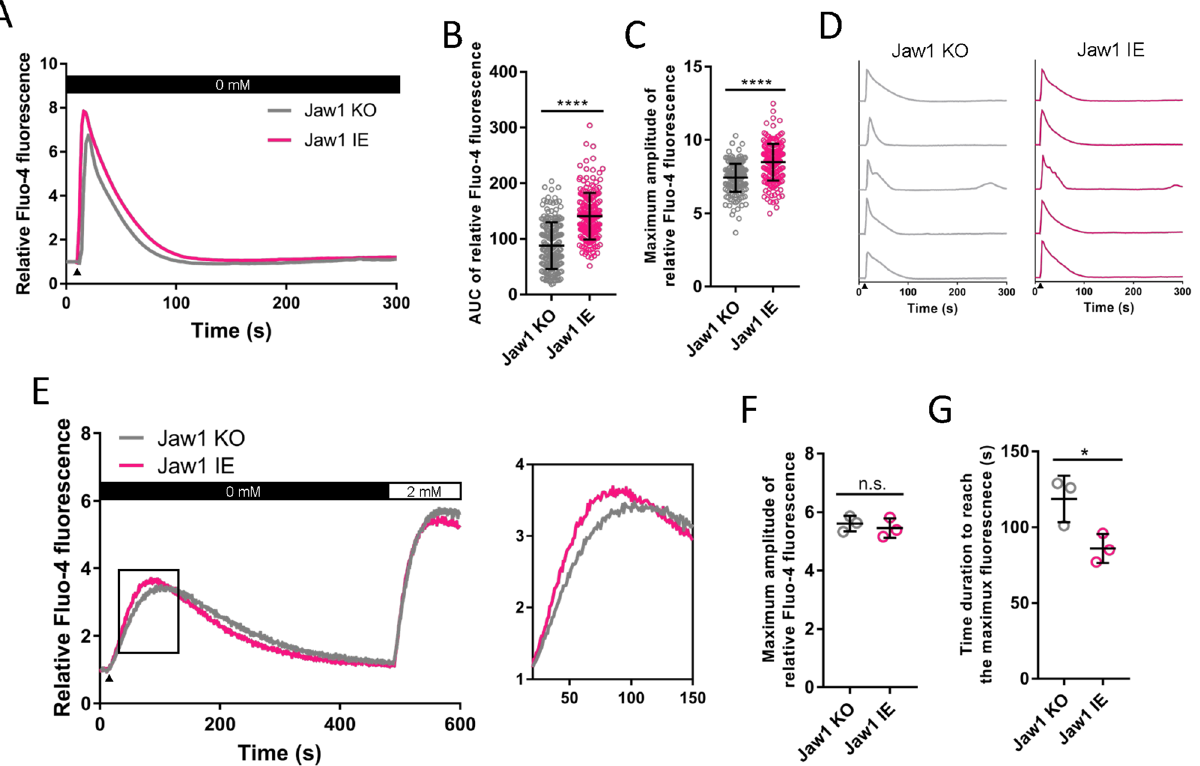
Figure 4. Jaw1 accelerates Ca 2+ efflux from ER . ( A , D ) Mean ( A ) or five representative ( D ) curves of the relative intensity upon 100 µM ATP stimulation under extracellular Ca 2+ free condition in Jaw1 KO and Jaw1 IE cells. n = 200. The closed triangle shows the time point of 100 µM ATP solution supplementation. ( B , C ) AUC ( B ) or maximum amplitude ( C ) of the relative intensity from ( A ). ( E ) Mean curves of the relative intensity upon Ca 2+ depletion in the ER by 2 µM thapsigargin supplementation in 0 mM Ca 2+ and replenishment with 2 mM Ca 2+ . The closed triangle shows the time point of 2 µM thapsigargin solution supplementation. The area surrounded with a black box is enlarged in the right. n = 3. ( F , G ) Maximum amplitude in SOCE ( F ) and time duration to reach the maximum amplitude in the Ca 2+ leakage ( G ) from ( E ). The error bar shows ± S.D.; n.s., non- significant; * p < 0.05; **** p < 0.0001, Student’s t